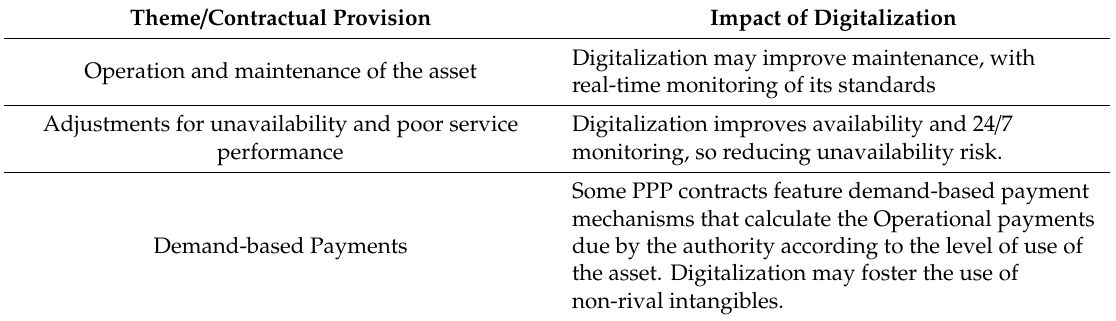
Table 4. Eurostat treatment of PPP contracts and the impact of digitalization. Theme / Contractual Provision Impact of Digitalization Digitalization may improve maintenance, with Operation and maintenance of the asset real-time monitoring of its standards Adjustments for unavailability and poor service Digitalization improves availability and 24 / 7 performance monitoring, so reducing unavailability risk. Some PPP contracts feature demand-based payment mechanisms that calculate the Operational payments Demand-based Payments due by the authority according to the level of use of the asset. Digitalization may foster the use of non-rival